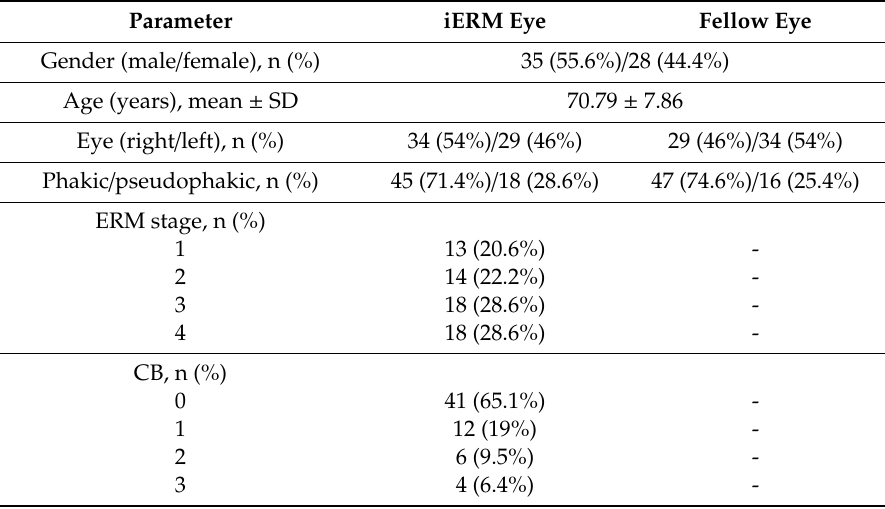
Table 1. Demographic and clinical characteristics of enrolled patients with iERM.